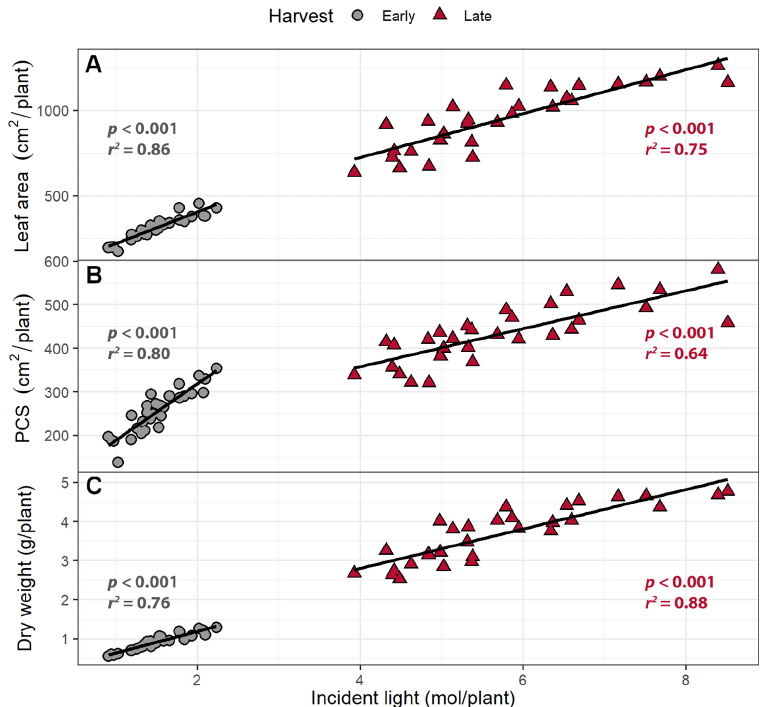
Figure 3. The correlation between ( A ) total leaf area and ( B ) projected canopy size (PCS) and total cumulative incident light (400–800 nm) over the growing period; ( C ) The correlation between incident light and shoot dry weight. Plants were grown under a photosynthetic photon flux density of 207 ± 13 µmol m − 2 s − 1 supplemented with varying amounts of far-red. The early harvest occurred 16 days after germination, while the late harvest occurred 25 days after germination.